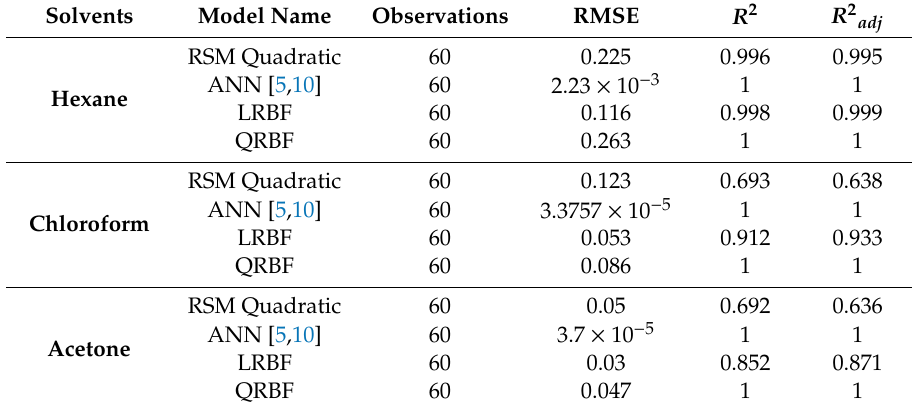
Table 4. Model Performance